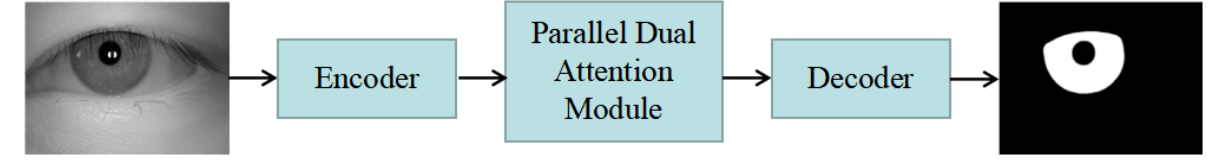
Figure 1. Overview of PFSegIris.